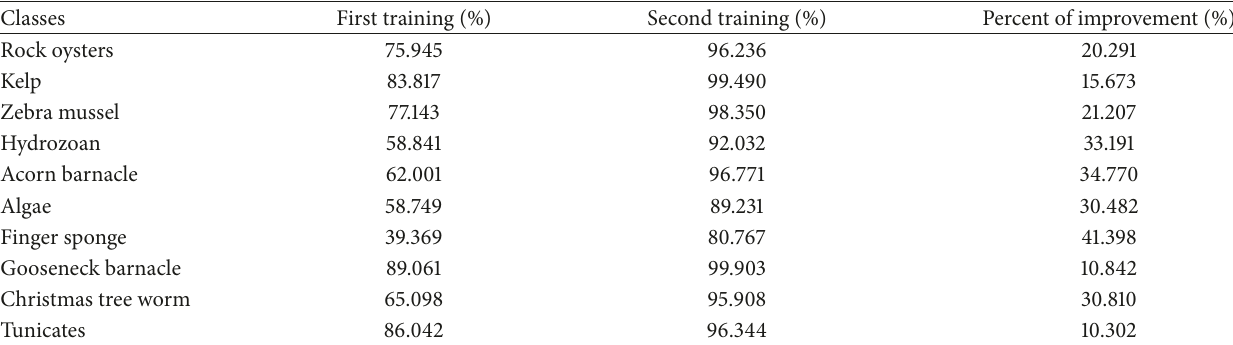
Table 4: Classification results of fouling (first and second training).